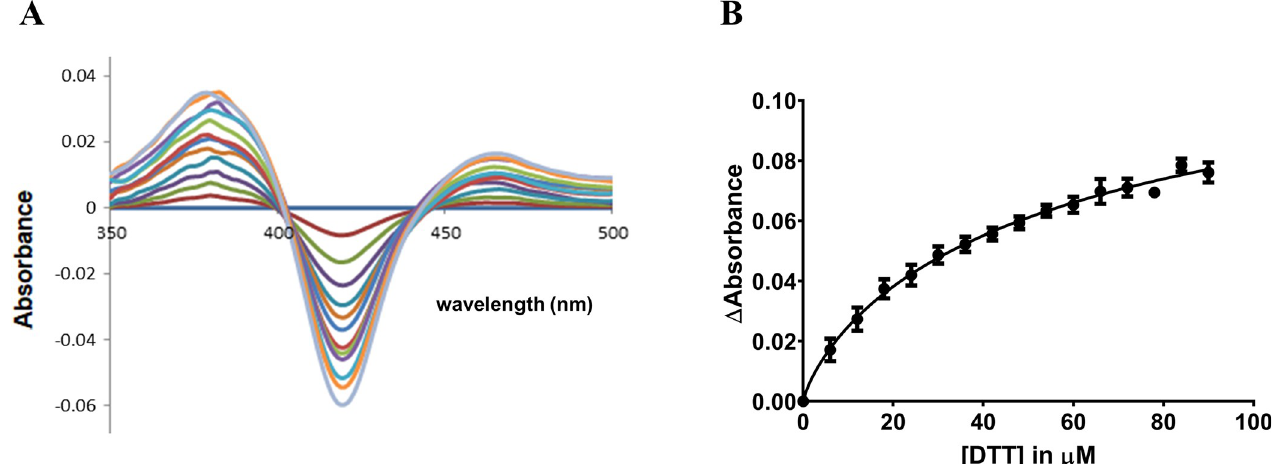
Fig 6. DTT to M11 binding. (A) UV/Vis absorbance difference spectra for binding of DTT to CYP BM3 mutant M11 at different DTT concentrations between 0 and 96 μ M (increasing in steps of 6 μ M, as indicated by the different lines with the dark-brown line corresponding to 6 μ M and the lightblue line to 96 μ M). (B) Differences in absorbance between 380 and 420 nm at the different DTT concentrations as used for fitting apparent values for dissociation constant K D . Averages are given for triplicated experiments, together with associated error bars.